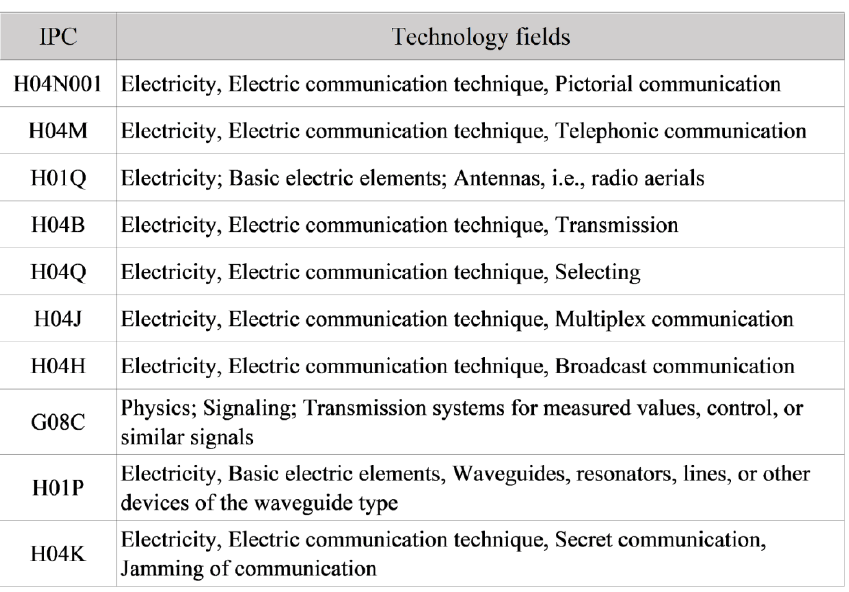
Fig. 11 Definitions of IPC numbers in telecommunications.